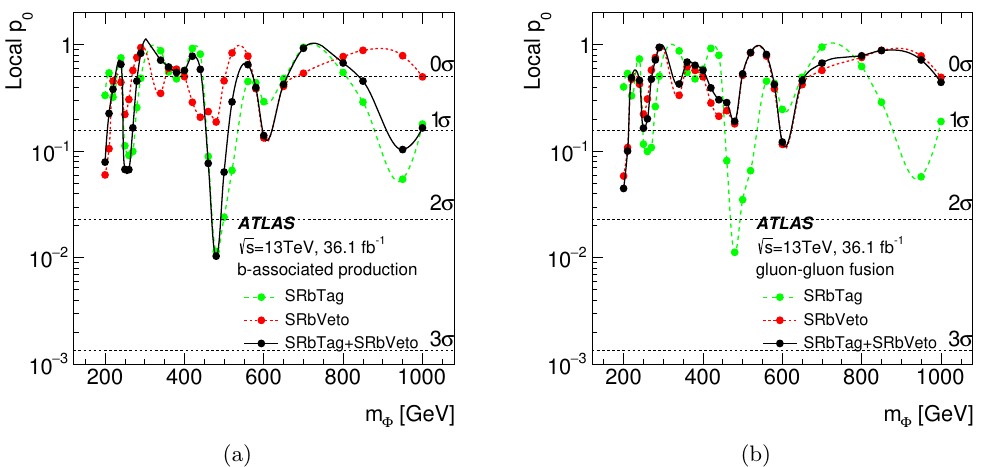
Figure 3 . Observed p -values as a function of m (cid:8) for (a) a bb (cid:8)-only (cid:12)t and (b) a ggF-only (cid:12)t. The dotted line corresponds to the data in the SRbTag only, the dashed line to the data in SRbVeto only, and the solid curve to the combination of the two data categories. All three (cid:12)ts include data from all control